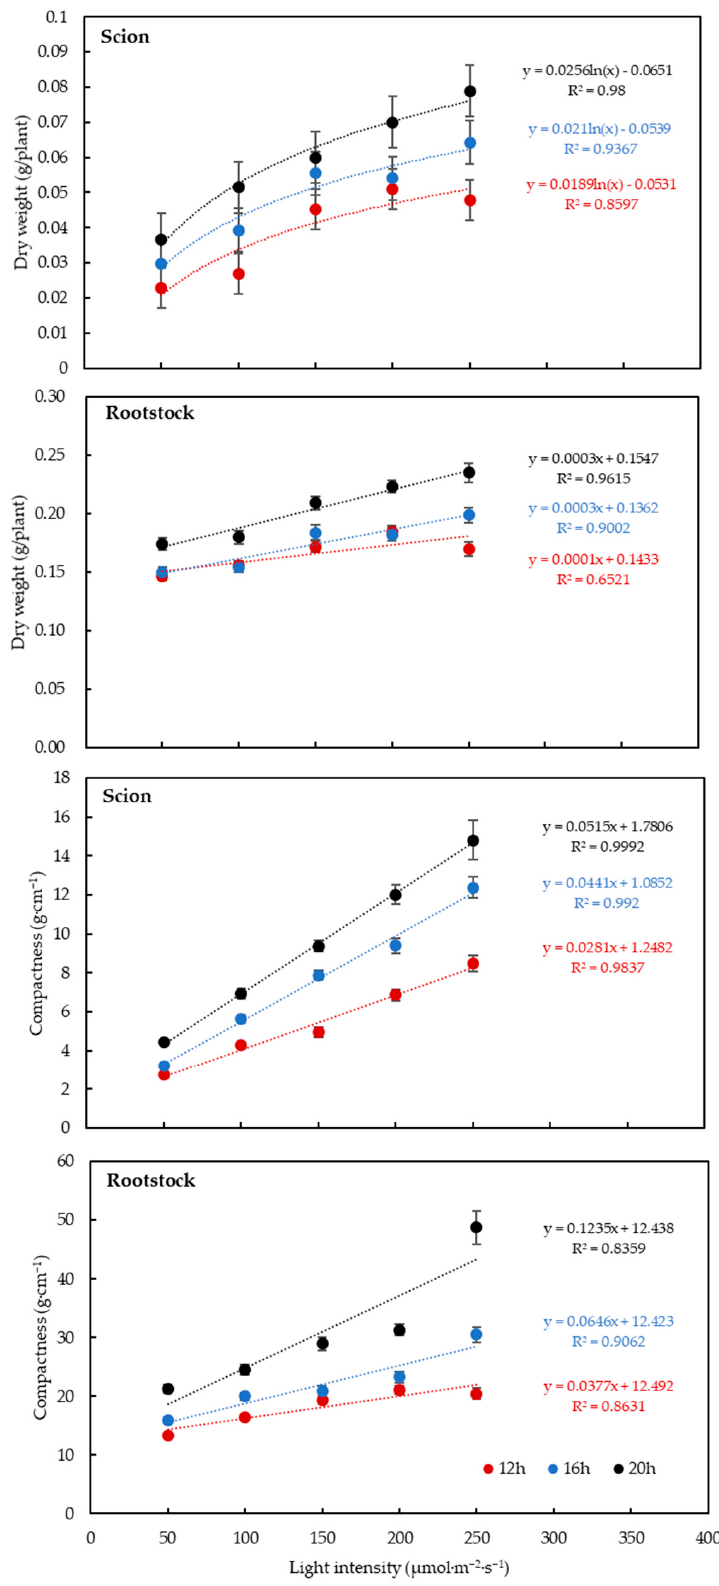
Figure 9. Regression analyses of the dry weight and compactness of cucumber scions and rootstocks as affected by the different air temperature and light intensity treatments in a PFAL. The values of each point represent means for 3 replicates with 7 samples and standard errors.